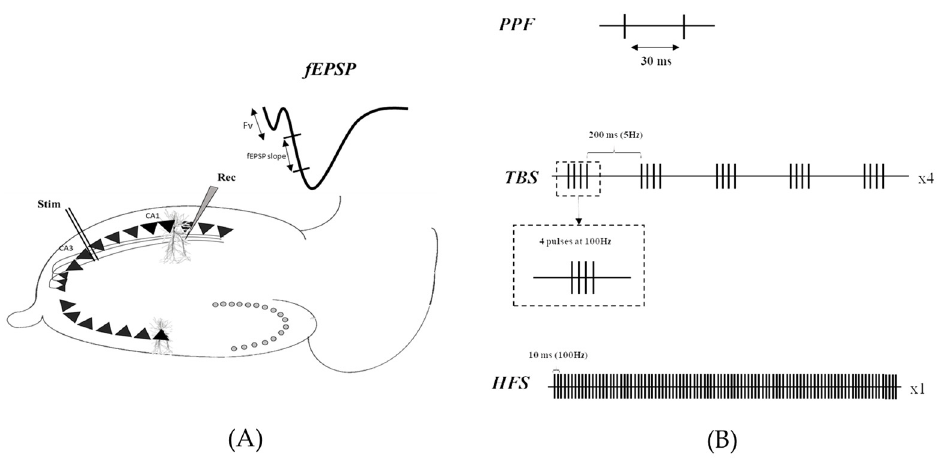
Figure 4. ( A ) Experimental setup, showing stimulating (Stim) and recording (Rec) electrodes placed in the stratum radiatum of the Schaeffer collateral and CA1 area, respectively. ( B ) Stimulation pattern of either HFS or TBS used to induce LTP.